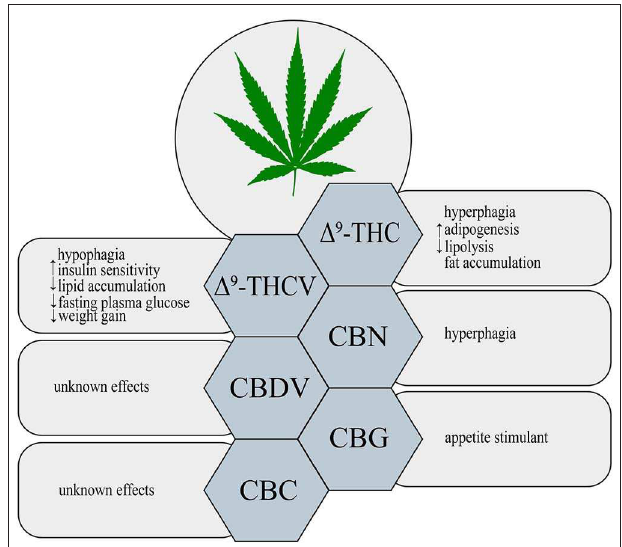
FIGURE 1 | Metabolic effects of different phytocannabinoids. ↑ , increase; ↓ , decrease; 1 9 -THC, 1 9 - tetrahydrocannabinol; 1 9 -THCV, 1 9 -tetrahydrocannabivarin; CBN, cannabinol; CBDV, cannabidivarin; CBG, cannabigerol; CBC,